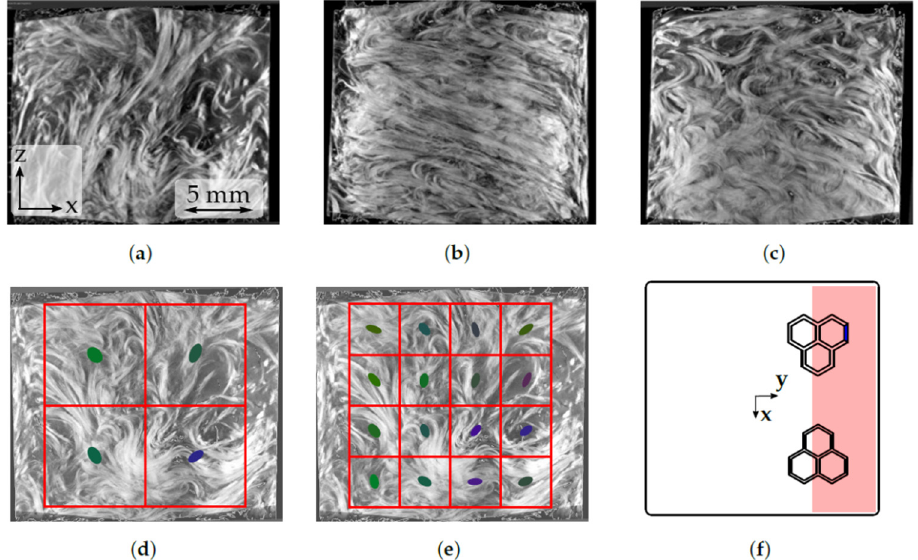
Figure 5. Figure 5. CT scan of the back wall of three identical trials molded with process Configuration A, ( a – c ). All three show different fiber orientation states even though they are molded from the same material, with the same process conditions and extracted from the same location. Evaluation meshes with 4 cells ( d ) and 16 cells ( e ). These are used for the fiber orientation analysis of the walls in ( a – c ). The total volume and position of the evaluation mesh is the same for each number of cells. The position of the walls shown in ( a – c ) is highlighted in blue in ( f ). The red area shows the position of the initial charge in Configuration A.